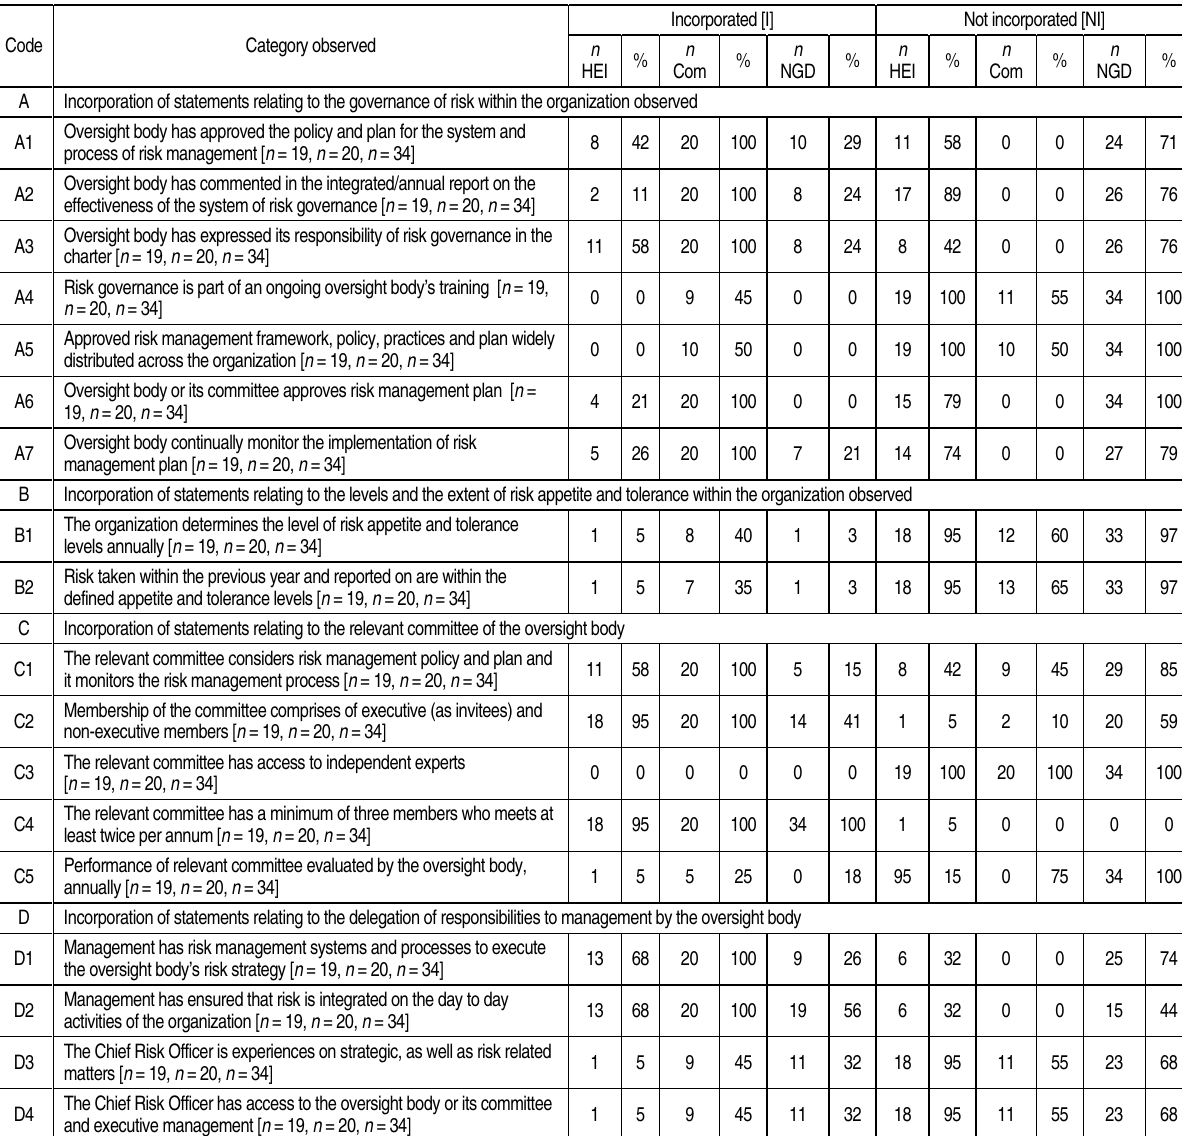
Table 1. Incorporation of statement relating to the governance of risk, tolerance and appetite, relevant committee and delegation of responsibilities